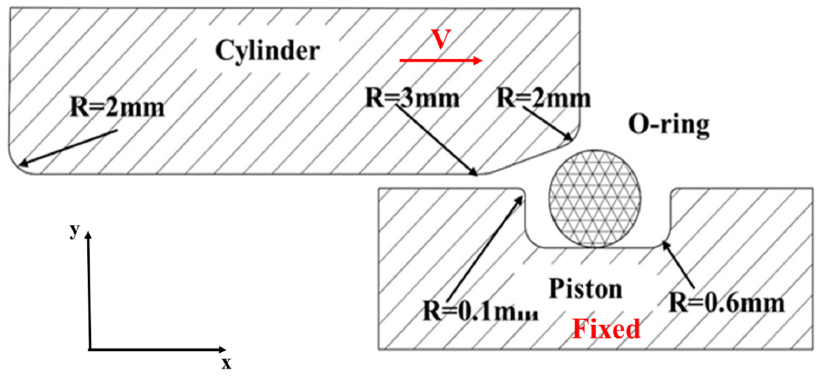
Figure 4. The geometric model for analysis.